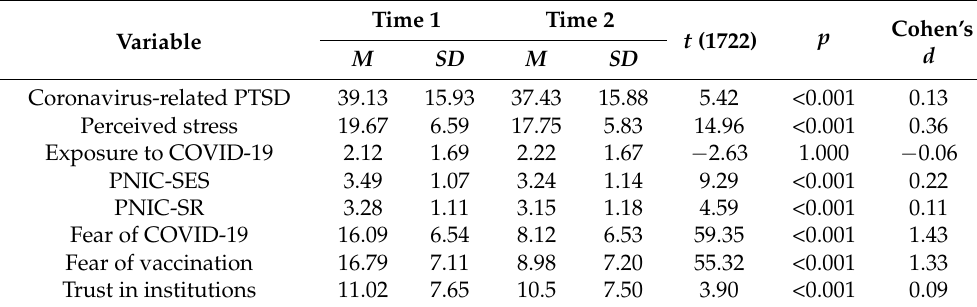
Table 1. Differences in mental health indices between T1 and T2 ( N =